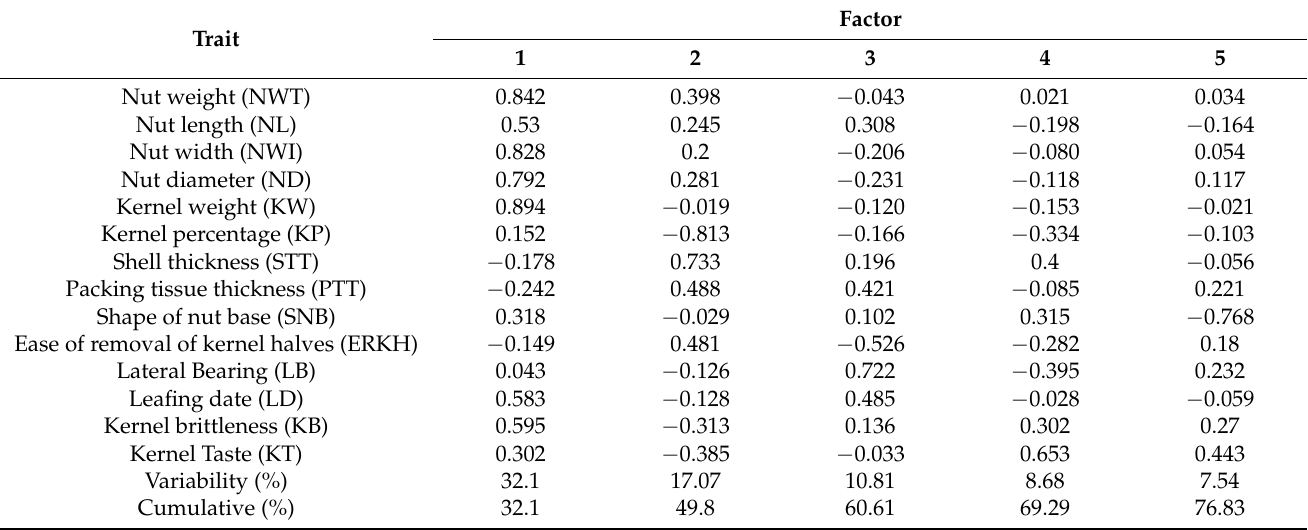
Table 5. Loadings for the first five phenological trait factors from walnut genotypes and cultivars.